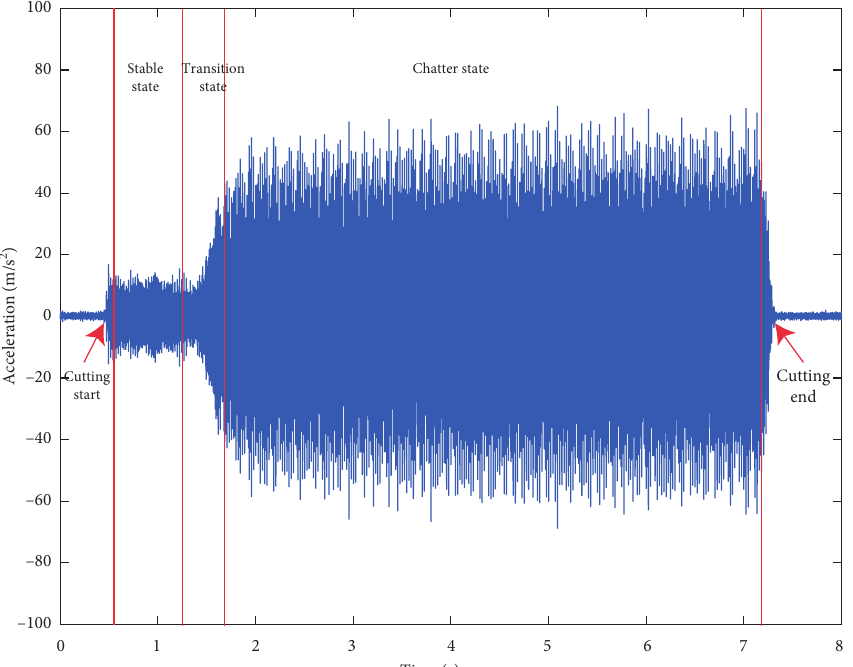
Figure 5: The process of chatter occurrence and development in the time domain under cutting conditions: spindle speed 7500r/min, axial depth of cut 0.4mm, radial depth of cut 0.1mm, and feed rate